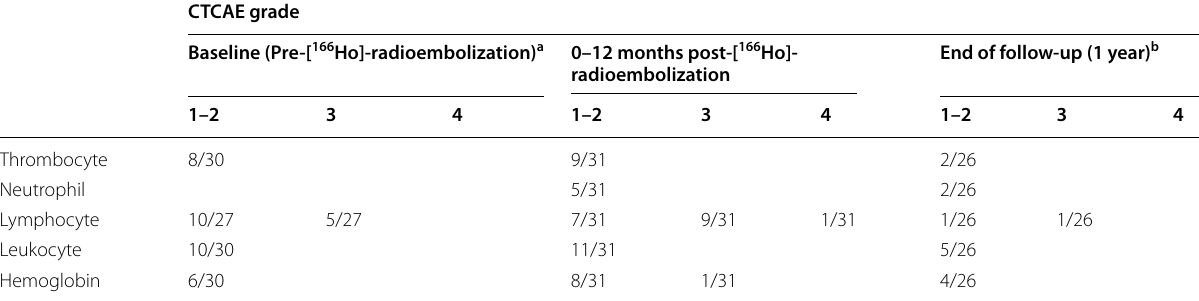
Values are n/available observed patients with the maximum observed toxicity grade during the designated period of follow-up. CTCAE grades at pre-[ 166 Ho]- radioembolization were counted when the grade was higher than at pre-PRRT, CTCAE grades in post-[ 166 Ho]-radioembolization follow-up were counted when the grade was higher than at baseline a Several values not available due to missing data at pre-PRRT b Five patients did not reach the 12-month